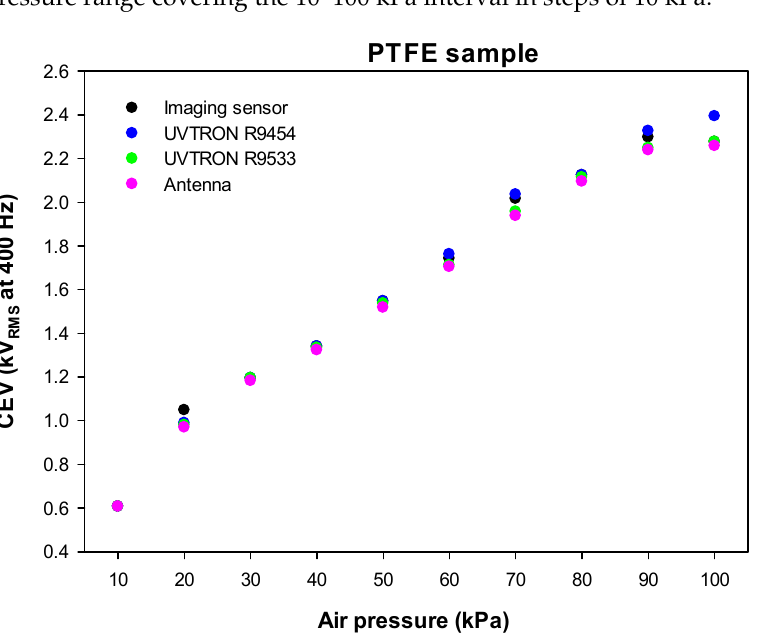
Figure 4. Normalized frequency response of the UVTRON R9454 sensor.